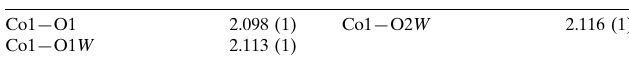
Selected bond lengths (A˚ ).